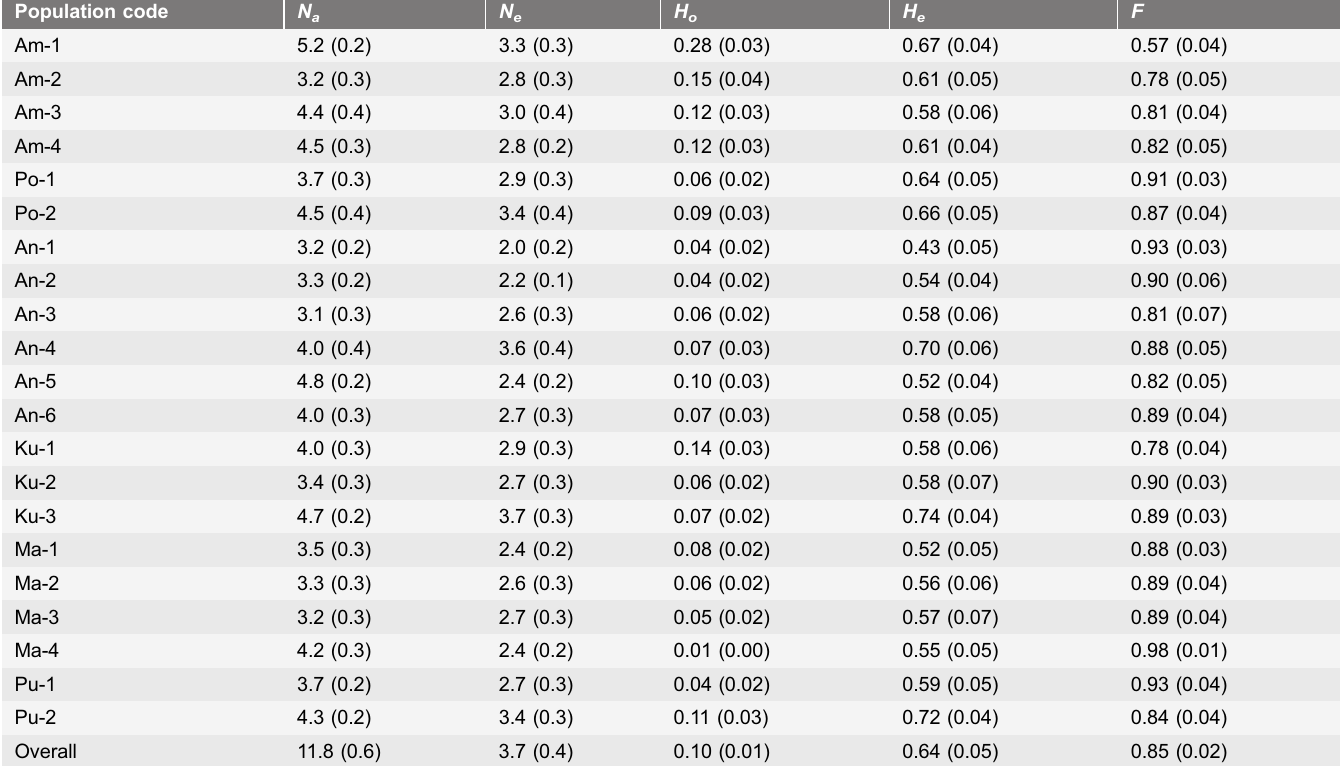
Table 3. Parameters of genetic diversity in 21 weedy rice populations from Sri Lanka based on 23 SSR primer pairs. Population code N a